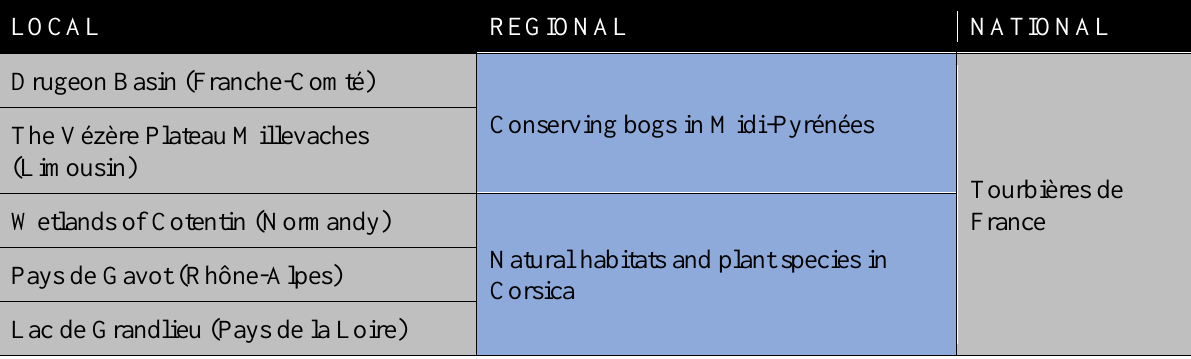
Table 2. Former LIFE programmes (1992–2001), classified according to their geographical range of